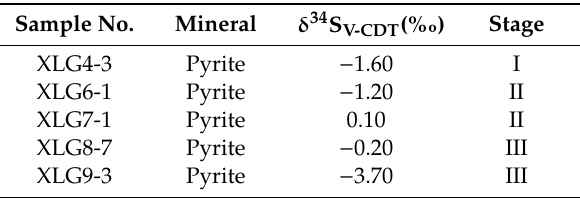
Table 3. δ 34 S V-CDT values of the Xialiugou deposit.